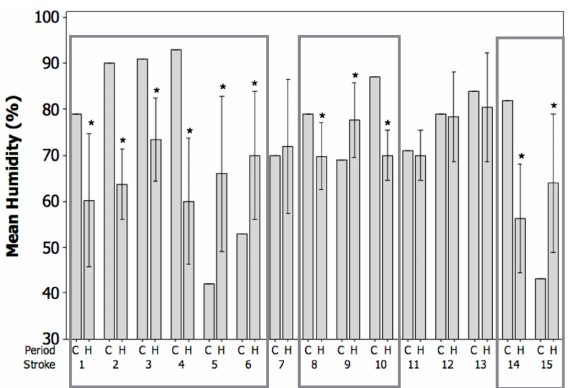
Figure 4. Mean humidity (%) in the control period (C) and the mean humidity ± 95% CI in the 7-day hazard periods (H) before the canine strokes ( n = 15). Significant effects (* p < 0.05) are displayed within boxes.